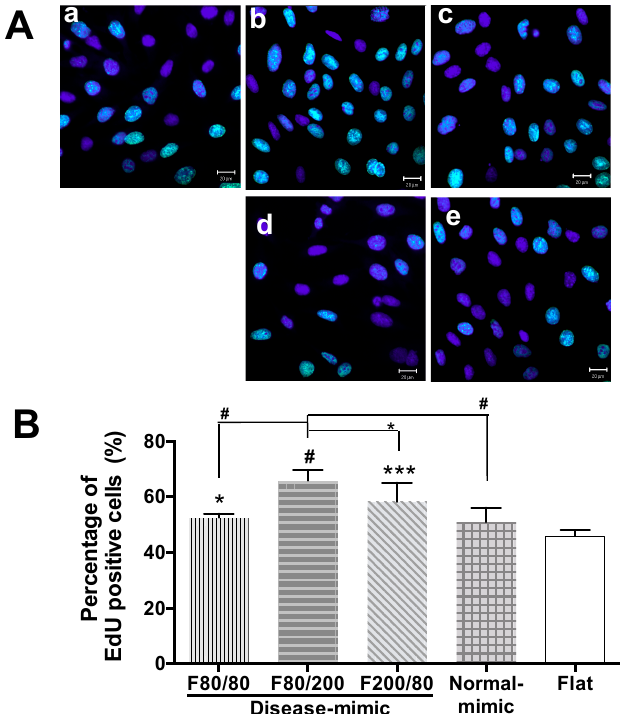
Figure 2. Proliferation of MES13 cells cultured on disease- and normal-mimic nanopatterns. ( A ) Cells were cultured on F80 / 80 (a), F80 / 200 (b), F200 / 80 (c), normal-mimic (d) and flat control (e) for 24 h, and then proliferation was determined by the 5-ethynyl-2’-deoxyuridine (EdU) assay. Fluorescence images show EdU incorporation into the nuclei of cells. EdU-positive cells are green, and nuclei stained with 4’,6-diamidino-2-phenylindole (DAPI) are blue. ( B ) Percentage of EdU-positive cells. Data are reported as means ± SEM for three independent experiments. Statistically significant at * p < 0.05, *** p < 0.0005, and # p < 0.0001 Analysis of Variance (ANOVA). Scale bar = 20 µ m.